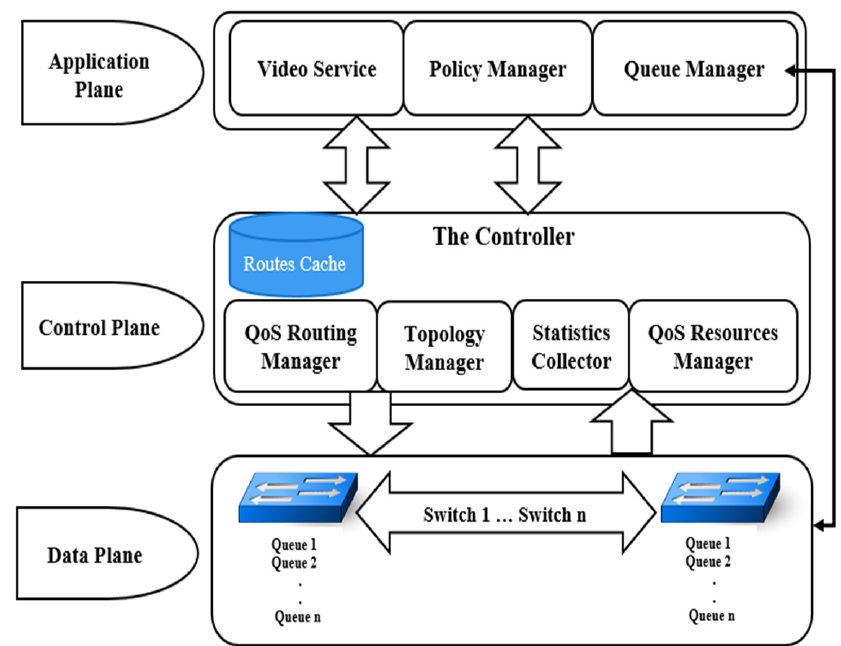
Figure 1. The VQoSRR SDN architecture.